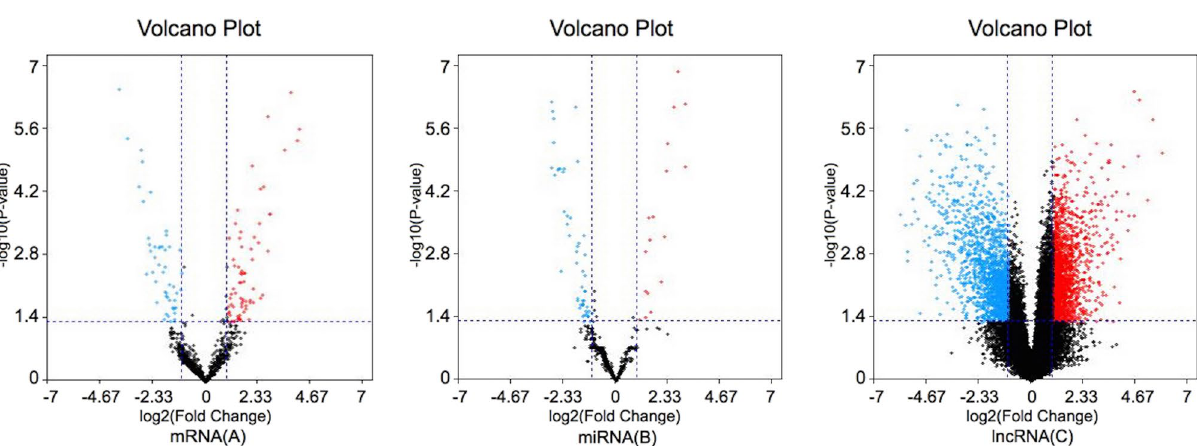
Figure 2. Volcano plots reflecting number, significance and reliability of differentially expressed RNAs in CN-AML compared with normal controls. The red dots indicate upregulation and blue dots indicate downregulation of mRNAs ( A ), miRNAs ( B ) and LncRNAs ( C ). The x-axis represents the value of log2 (Fold Change) and the y-axis represents the value of -log10 ( p